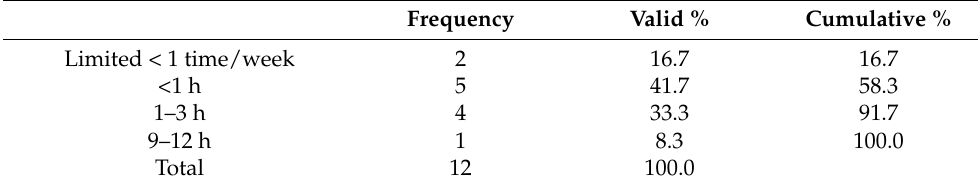
Table 4. Weekly hours of direct support by the mentor to co-workers.